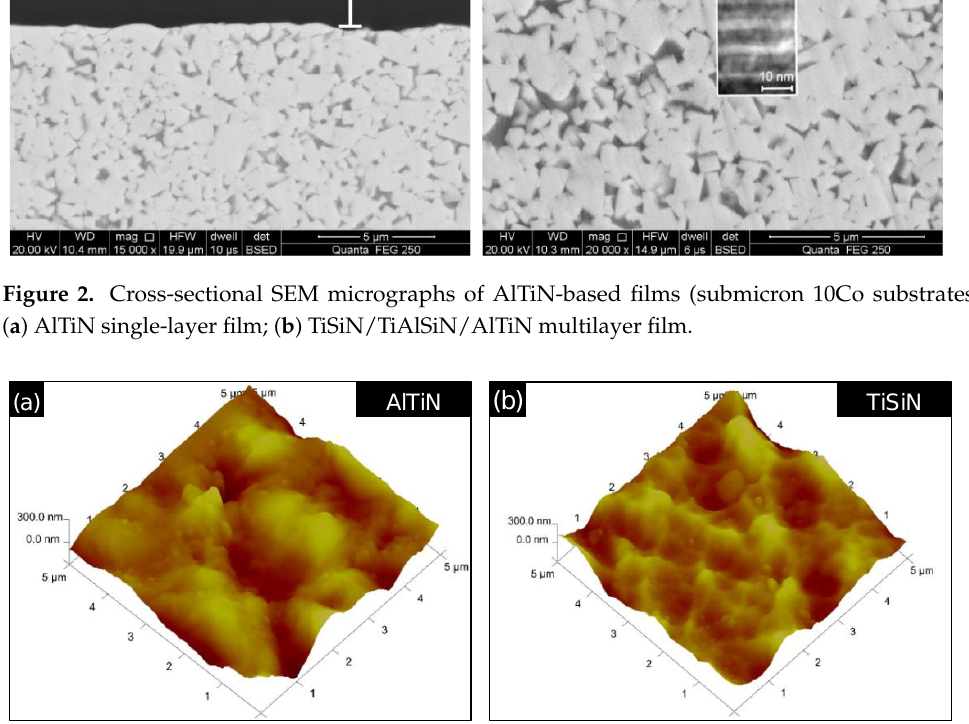
Figure 3. Three-dimensional topographic AFM images of the AlTiN-based films (submicron 10Co substrates): ( a ) the AlTiN single-layer; ( b ) the TiSiN surface layer of the multilayer film.